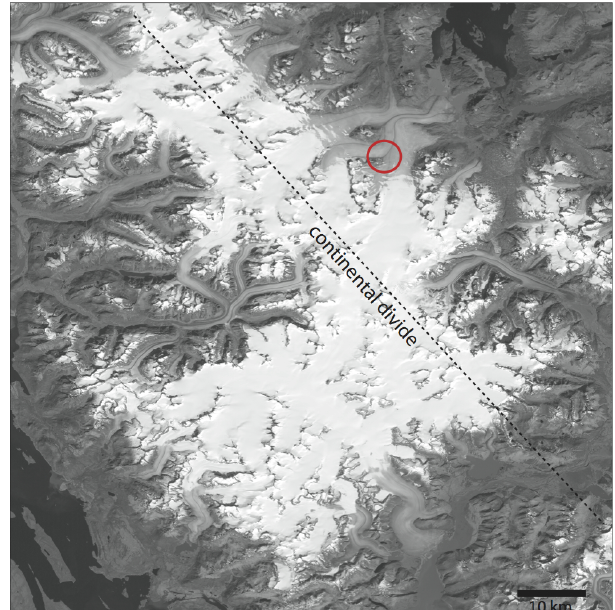
Fig. 1. Landsat 7 image (taken August 15, 2001) of the Juneau Icefield. The Llewellyn glacier study site is located at 59 ◦ 4’36.83”N, 134 ◦ 7’24.54”W, indicated by the solid red circle.